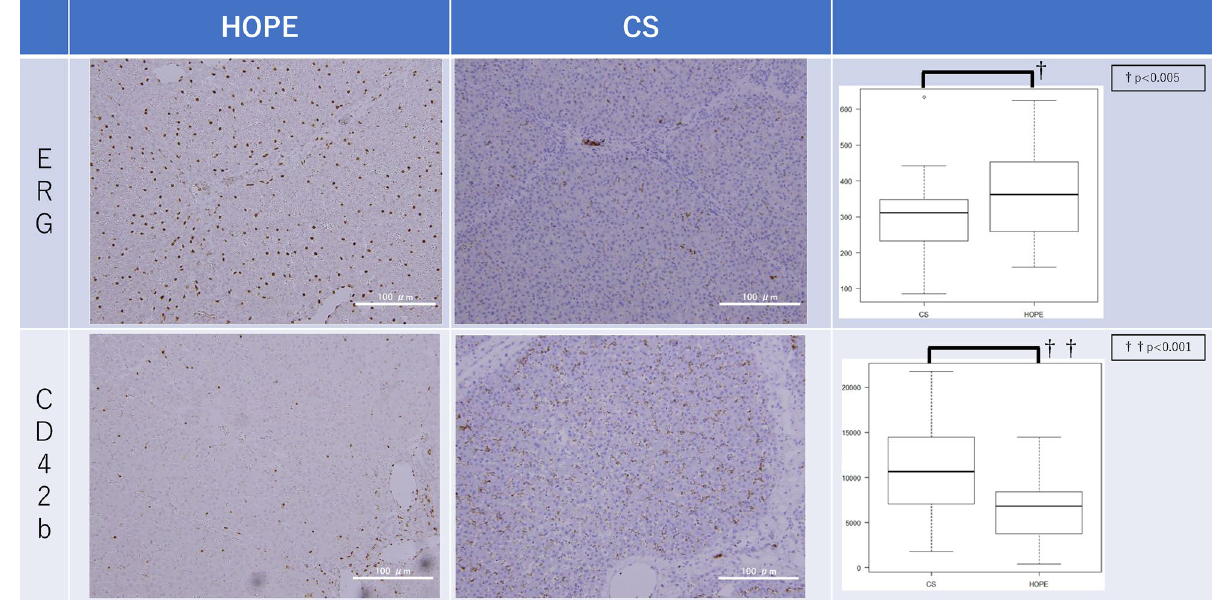
Figure 6. Immunohistochemistry. At the end of reperfusion, the number of anti-ERG staining-positive SEC nuclei counted automatically by ImageJ in the HOPE group (360.54 ± 118.87 per field) was significantly higher than that in the CS group (285.13 ± 107.87 per field) ( P = 0.002). At the end of reperfusion, the positive area of anti-CD42b staining counted automatically by ImageJ in the HOPE group (6317.06 ± 3235.14 per field) was significantly smaller than that in the CS group (10,761.50 ± 5643.620 per field) ( P < 0.001). CS cold storage, HOPE hypothermic oxygenated machine perfusion preservation, SEC sinusoid epithelial